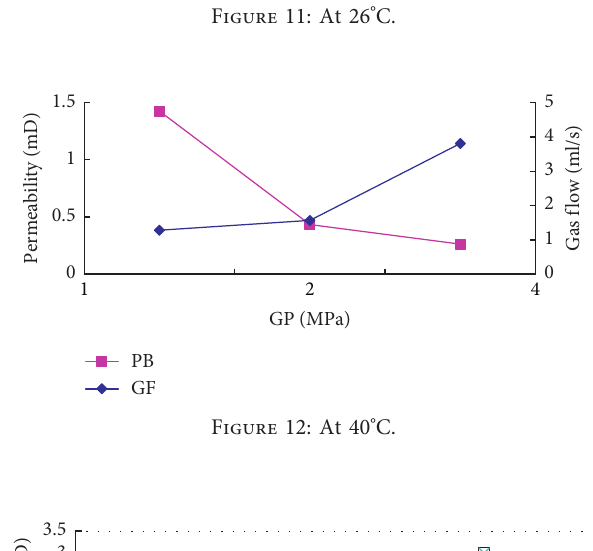
Figure 11: At 26 ° C.